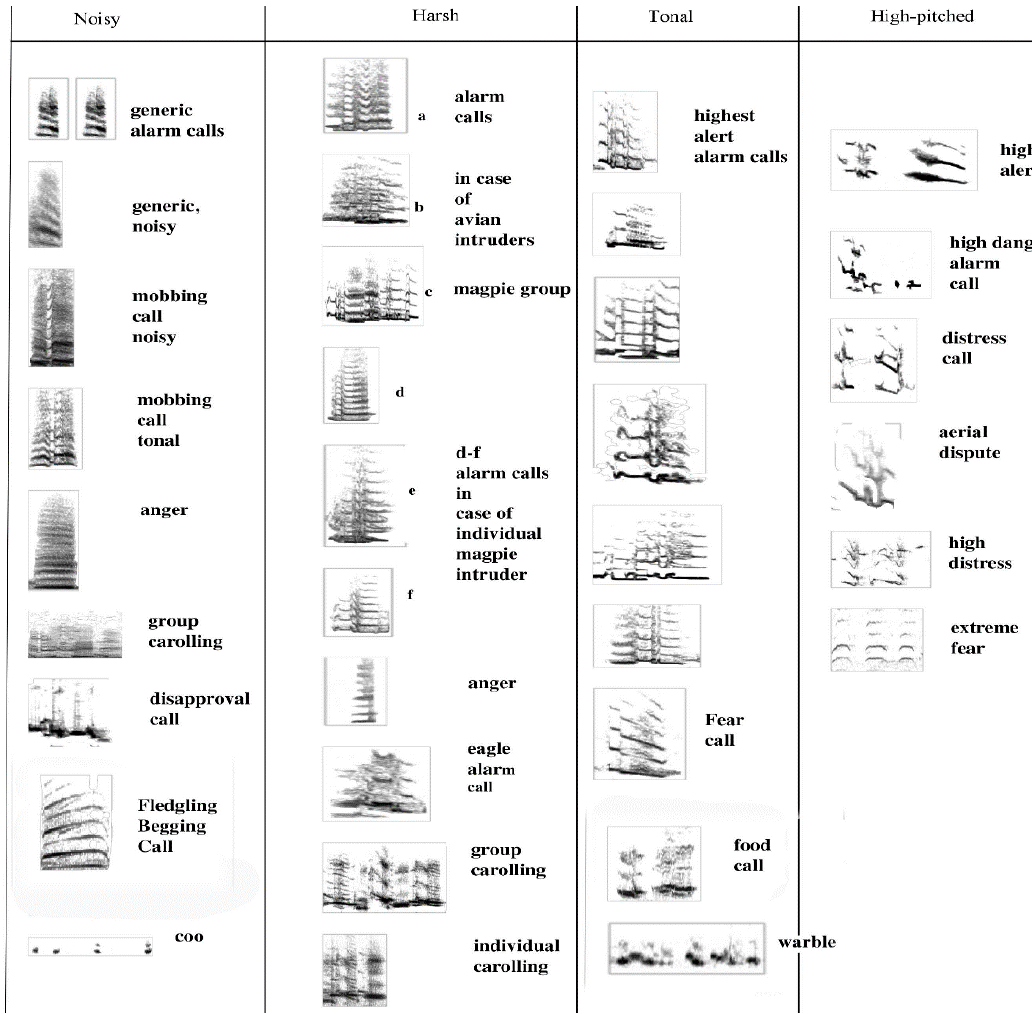
Figure 9. Acoustic characteristics of magpie vocalisations: 33 distinct sounds that, even to the human ear, have distinct sound profiles. The context and function are identified next to the call. Column 1 :